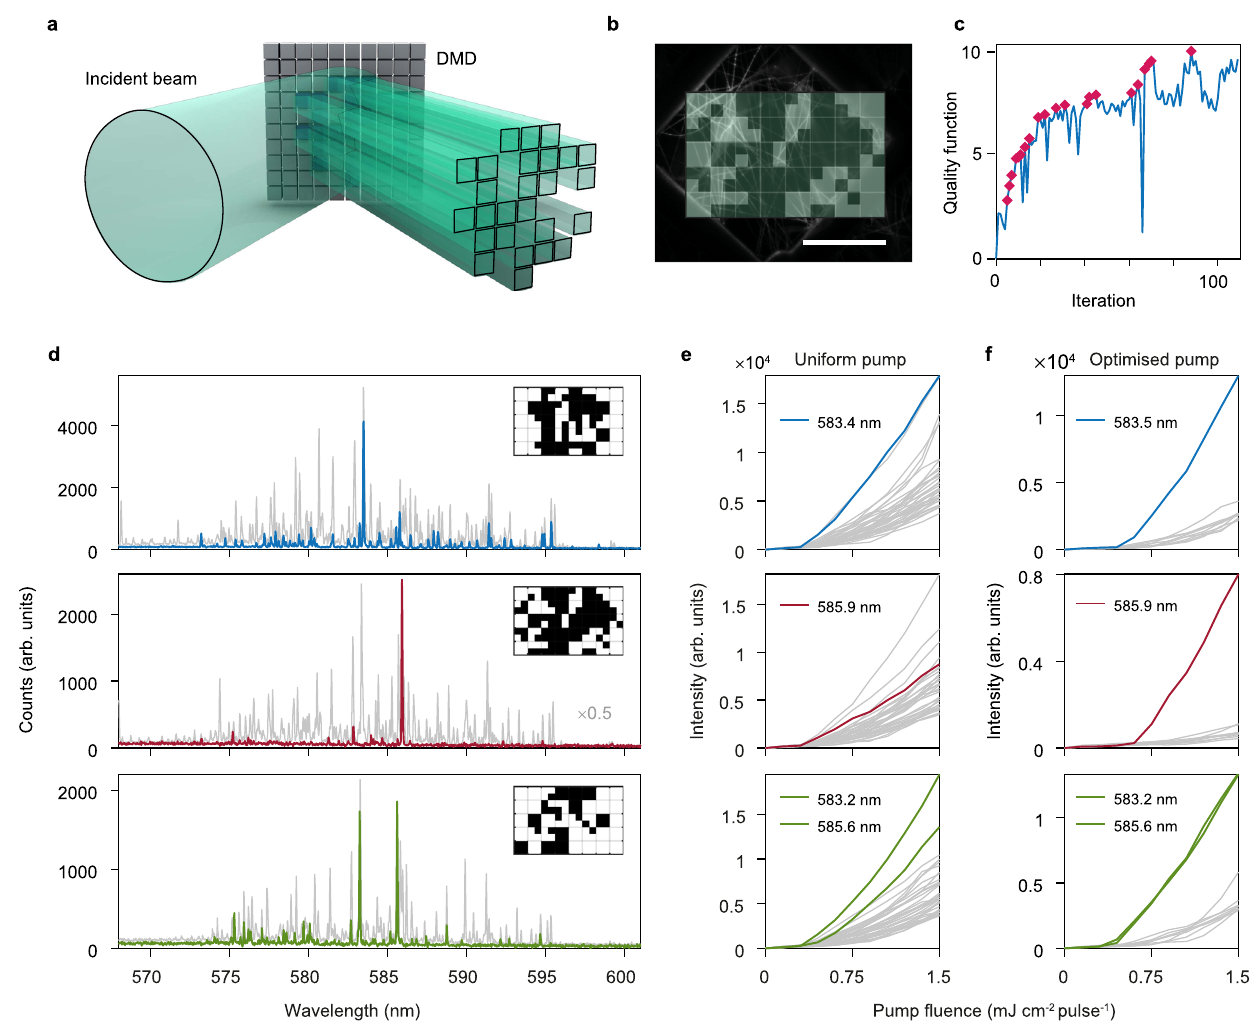
Fig.3|Experimentalspectralcontrolofnetworklasers.a , b Lasingmodesinthe network laser are controlled by selective illumination of the individual network links. This is done by shaping the pump laser using a digital micromirror device (DMD). The patterns are projected on the sample and cover a rectangular area of 300×480 μ m 2 (scale bar=200 μ m). c Plot of the quality function at each iteration fortheoptimisationofmodeat585.9nm(showninredin d – f ).Thepumppatternis optimised using a derivative-free, greedy iterative algorithm (see Methods) that optimises the quality function Equation 1 to improve the mode suppression ratio, leadingtoaprogressivesuppressionoftheunwantedmodeswhiletheselectedone is maintained. Pink dots indicate improvements in the quality function during the